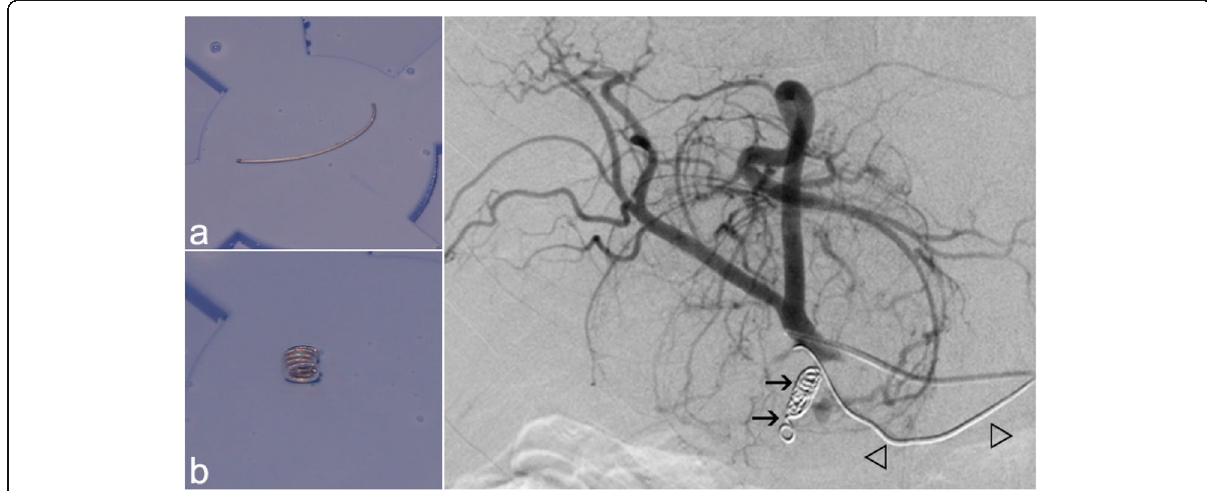
Fig. 5 Correlation of two different HydroCoil configurations in a patient prepared for a selective internal radioembolization procedure. The filament-like HydroCoil configuration ( a ) allows access to narrow vessels, such as the right gastric artery, in a retrograde fashion (arrowheads) using the expandable capabilities of the HydroCoil to induce vascular occlusion. After preparation at 55 – 70 °C ( b ), the compact configuration of a curled HydroCoil is useful for the proximal occlusion of the gastroduodenal artery (arrows) to avoid particle reflux during the radioembolization